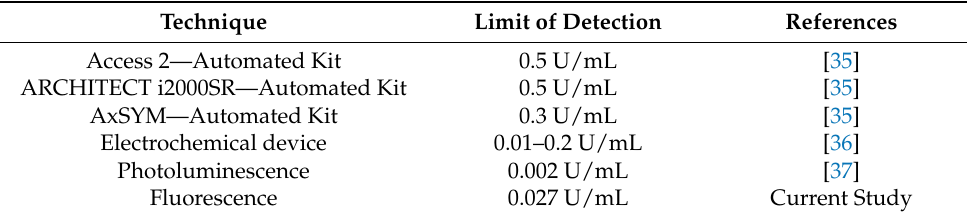
Table 2. Comparison of techniques described in the literature for CA 15-3 measurement.